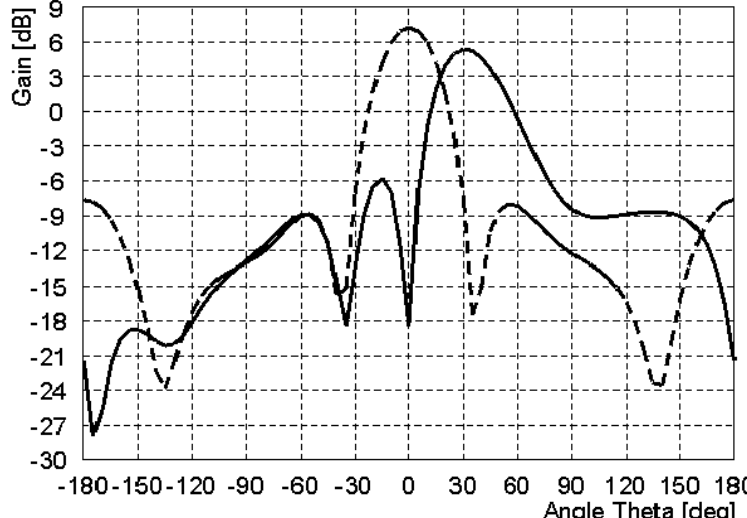
Fig. 2. Antenna pattern of the four-element antenna